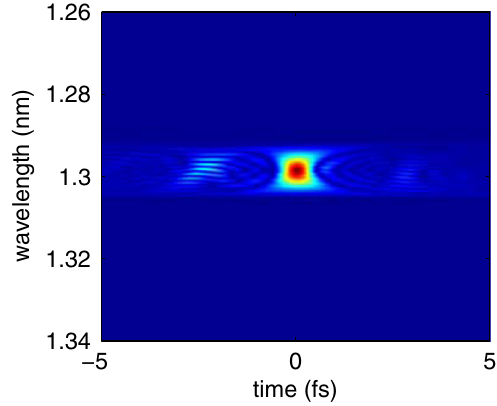
FIG. 5. Temporal profile of a single FEL radiation pulse at 34.4 m for the case of an 800 nm modulating laser. The radiation consists of a dominant central peak surrounded by two, smaller peaks separated by the laser